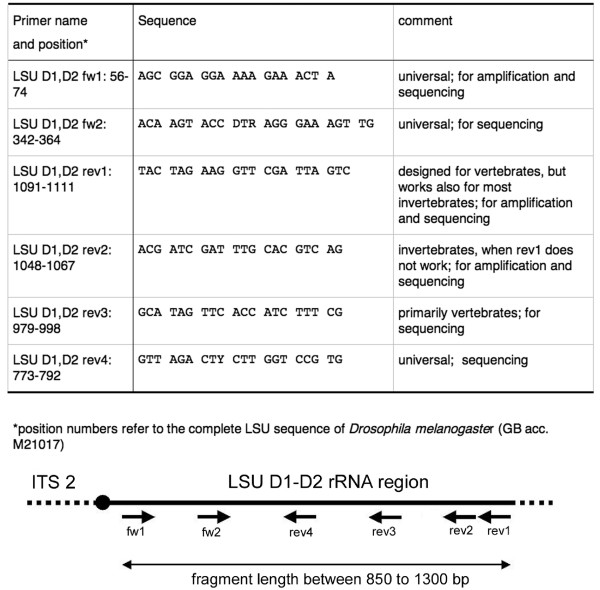
Primers used for amplification and sequencing of the D1-D2 LSU region. The primer positions in column 1 refer to the LSU sequence of Drosophila melanogaster (Acc. No. M21017). The sketch below indicates the approximate positions of the primers.